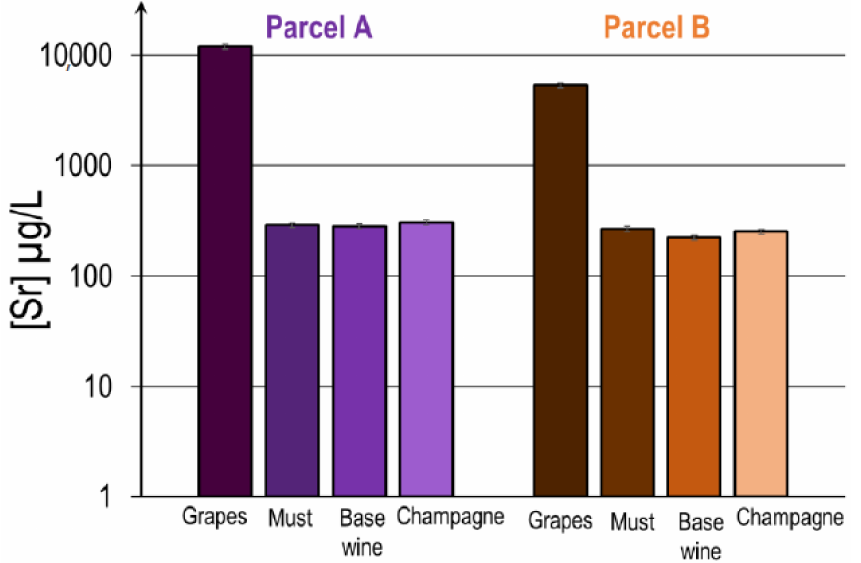
Figure 7. Evolution of the Sr concentration from grape to Champagne for two mono varietal parcels (A,B) (expressed in Log